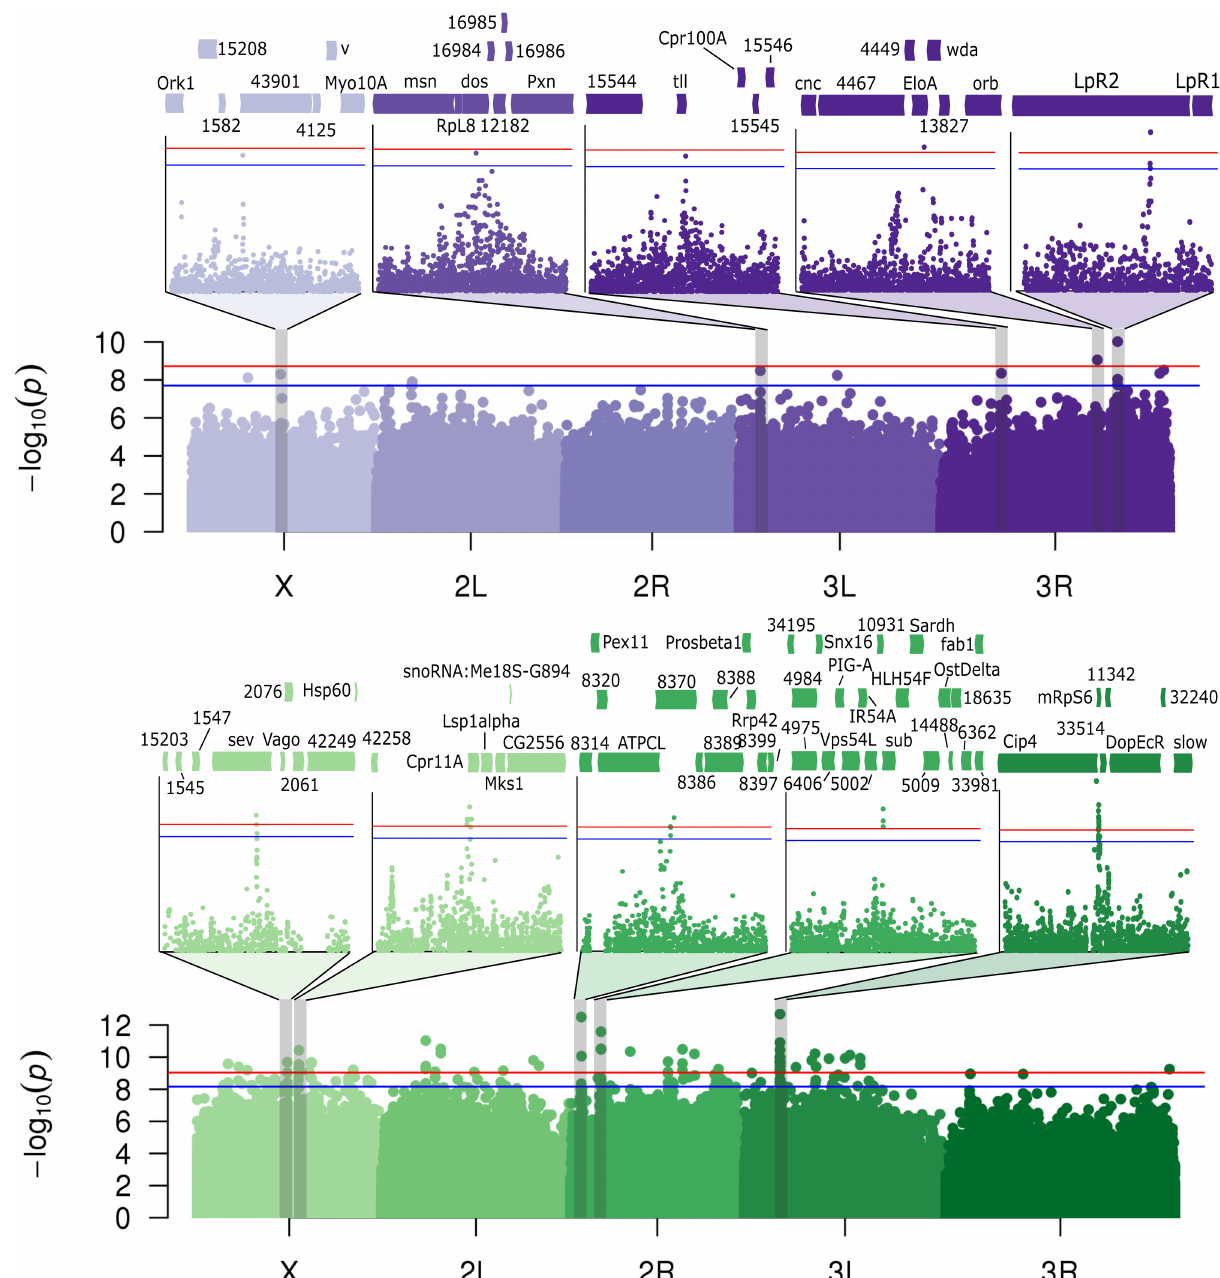
Fig 4. Genome-wide association of polymorphism in the DGRP with KV-induced titre and mortality. Manhattan plots showing the p-value for the effect of each polymorphism on viral titre (purple) and mortality (green). The top SNPs for each phenotype are shown in expanded inset panels, including surrounding genes. For clarity “CG” is omitted from gene identifiers. Horizontal lines show significance thresholds obtained through randomisation (p rand = 0.05 in blue; p rand = 0.01 in